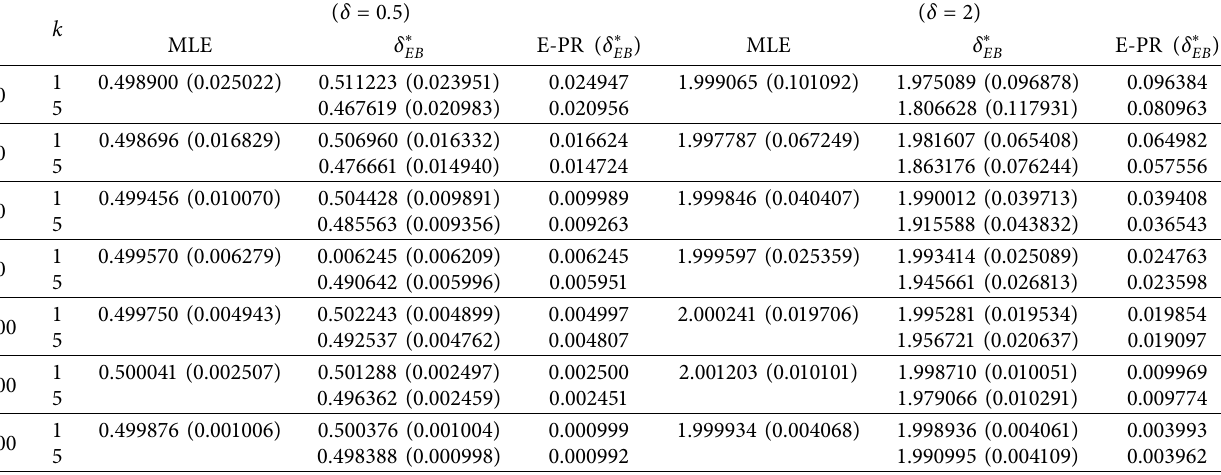
Table 2: E-B and E-PR estimates of SELF.